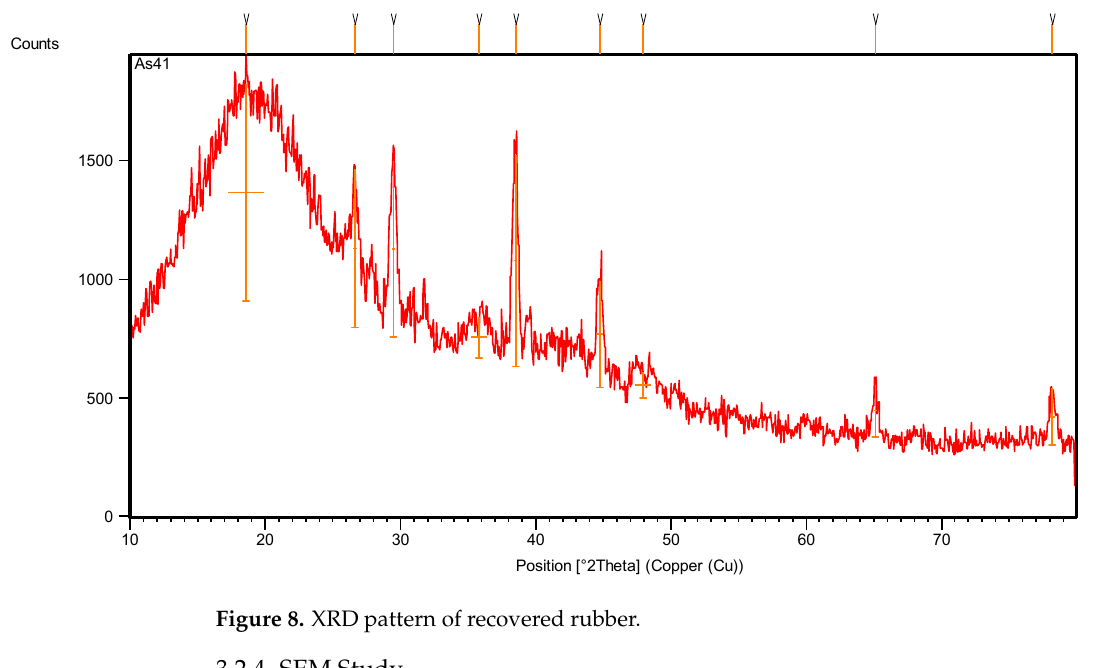
Figure 8. XRD pattern of recovered rubber.